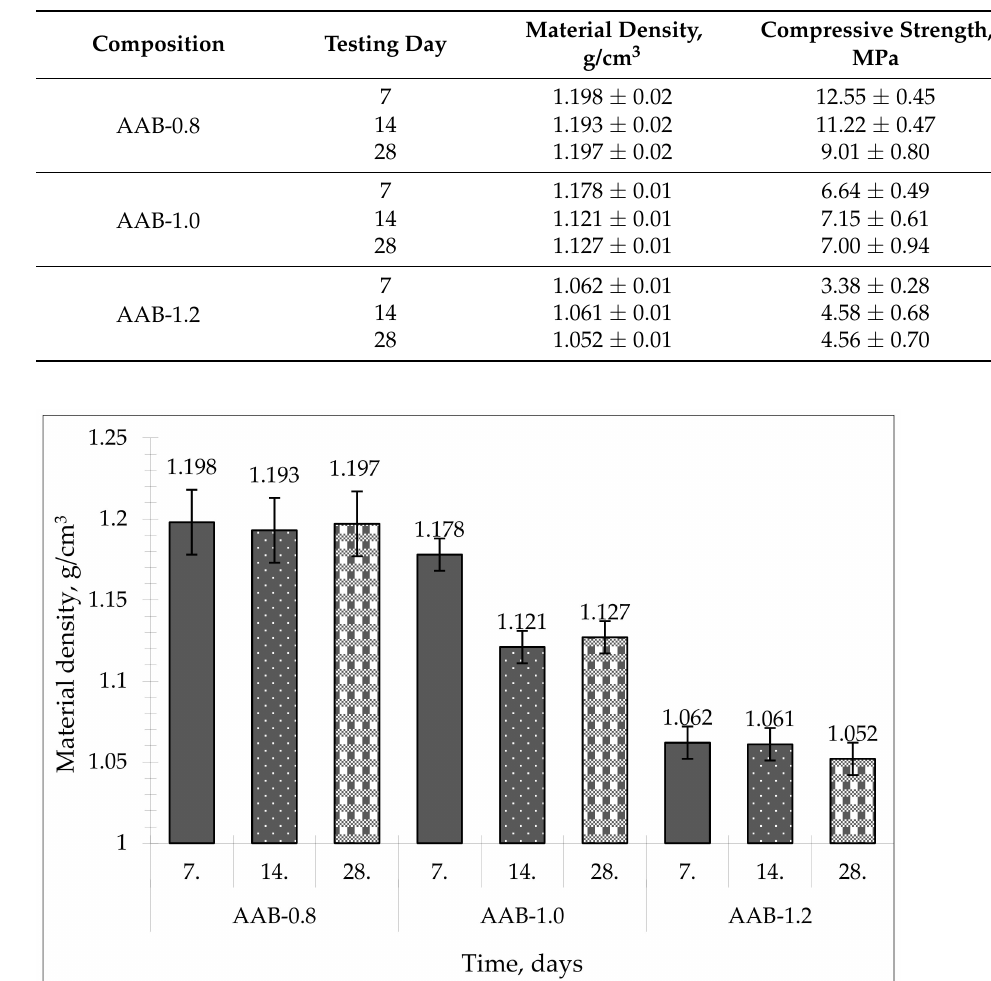
Figure 4. Material density of obtained alkali-activated